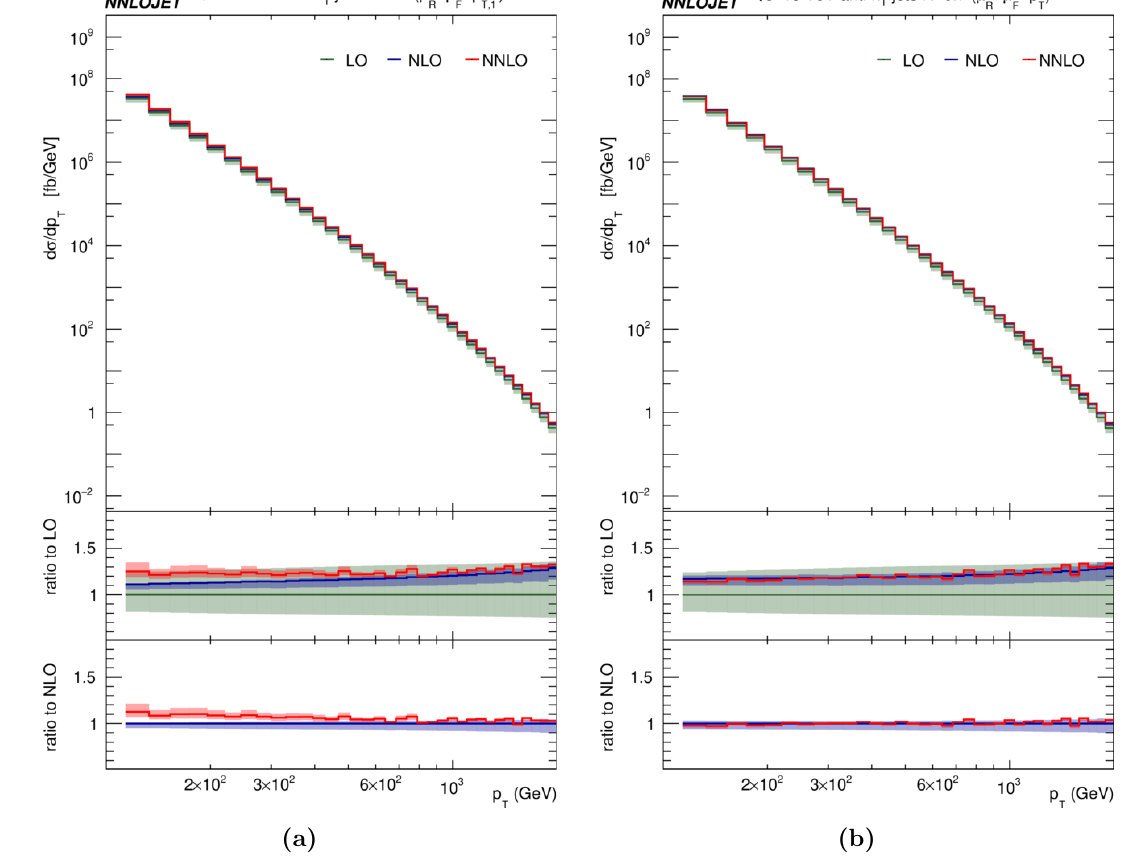
Figure 4 . Perturbative corrections to the single jet inclusive distribution at 13 TeV (CMS cuts, j y j < 4 : 7, R = 0 : 7), integrated over rapidity and normalised to lower order predictions. Central scale choice: (a) (cid:22) = p T ; 1 , (b) (cid:22) = p T